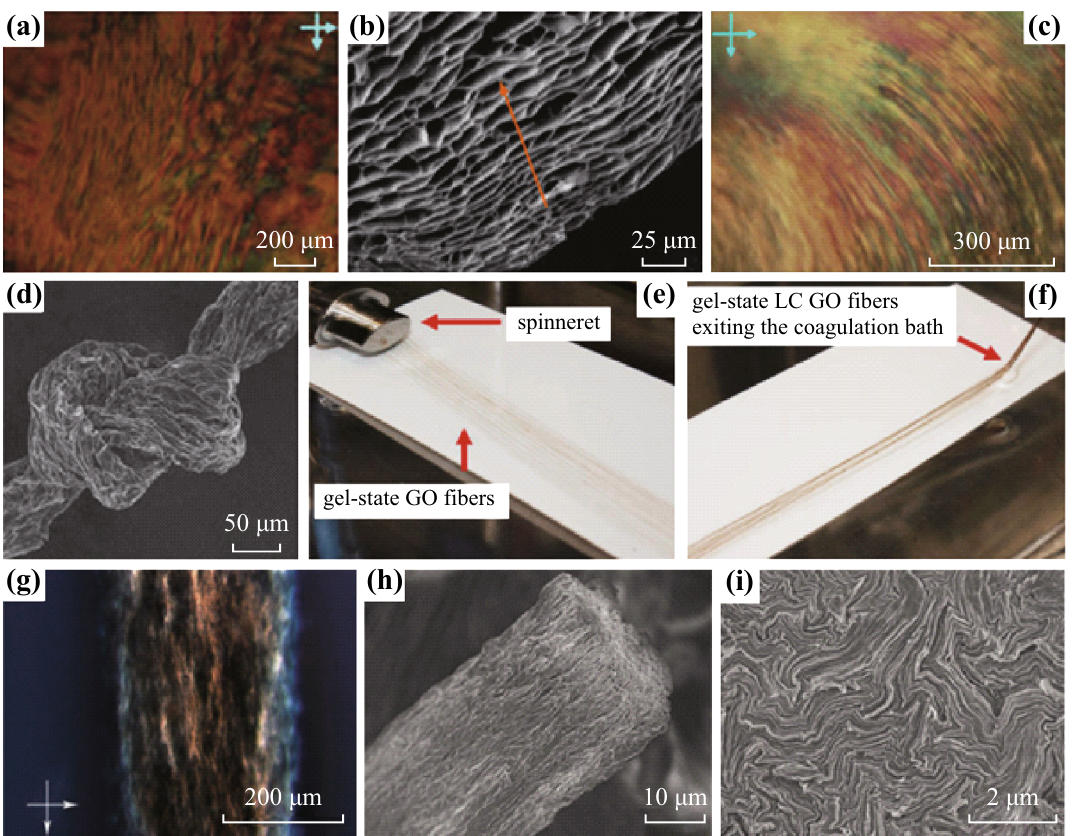
Fig. 9 a POM observation of GO aqueous dispersions with a fingerprint texture of chiral phase. b , c Cryo-SEM images and POM textures for GO chiral LCs. d a tight knot of GF. e , f photographs of GO yarns produced using a multi-hole spinneret. g POM observation of gel-state GO fiber showing birefringence. SEM images of a GO fiber h and its magnified cross section ( i ). a – d Reproduced with permission from Ref. [46]. Copyright 2011, Nature Publishing Group. e – i Reproduced with permission from Ref. [49]. Copyright 2013, Wiley–VCH